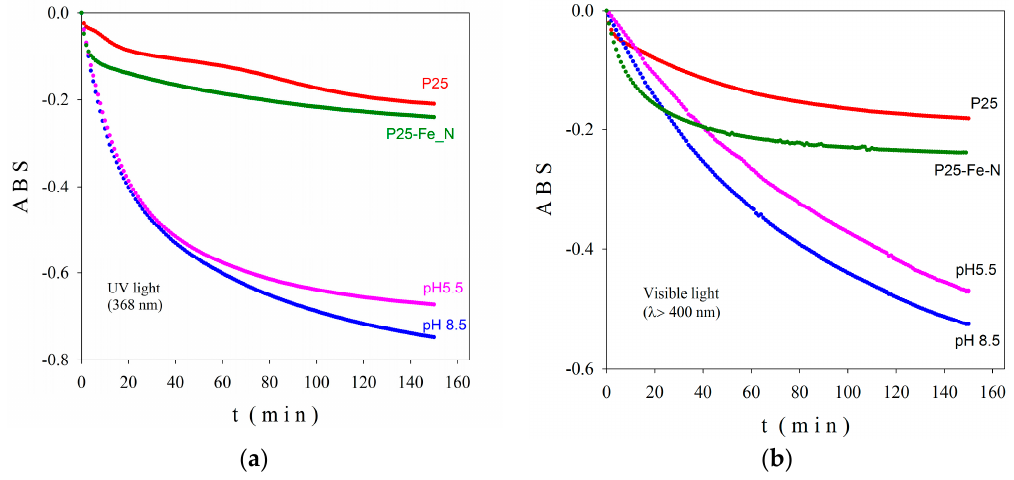
Figure 6. Absorbance (ABS) for the investigated samples in UV ( a ); and visible light ( b ).